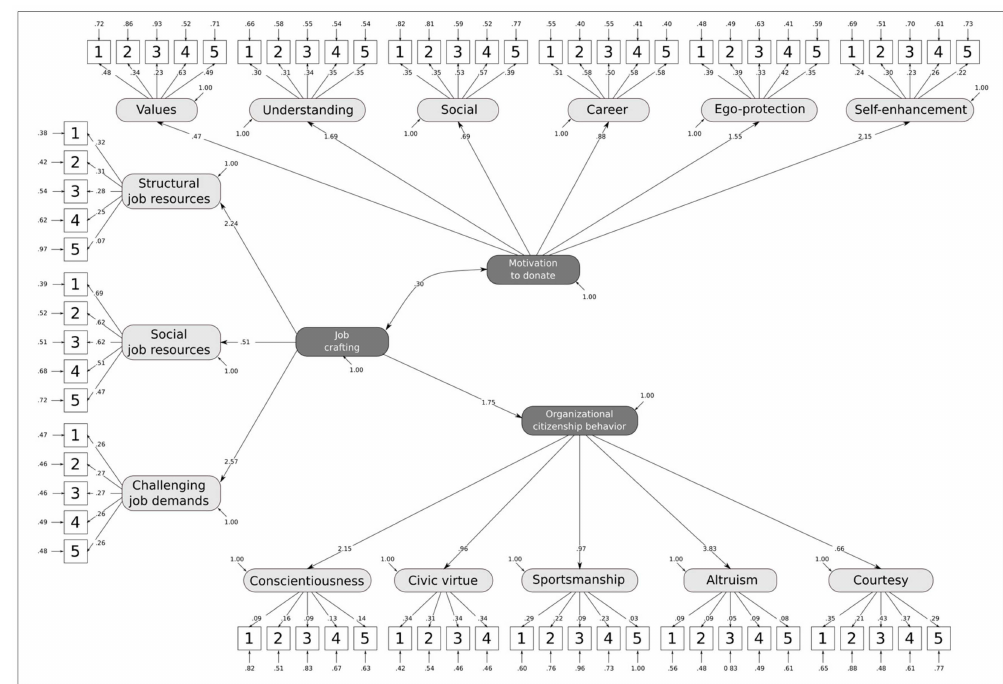
Figure 2. Path diagram and standardized parameters of the selected